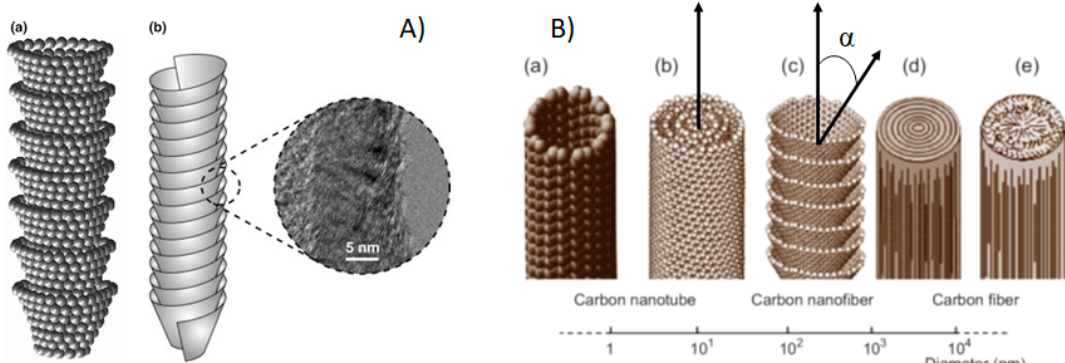
Figure 4. Panel ( A ): (a) 3D representation of cup-stacked graphene layers in a single CNF, and (b) Simplified schematic of stacked-cup carbon nanofiber helical structure with inset showing TEM image of inclined orientation of grapheme planes along the side of structure with respect to nanofiber axis. Image taken from [76]. Courtesy of Elsevier. Panel ( B ): Schematic of size and morphology distribution of various nanotubular structures that shows the main difference in the structure between carbon nanofibers and carbon nanotubes. (a) single wall carbon nanotube, (b) multi walled carbon nanotube, (c) carbon nanofiber, (d and e) carbon fibers of different complexity. Reprinted from [68].